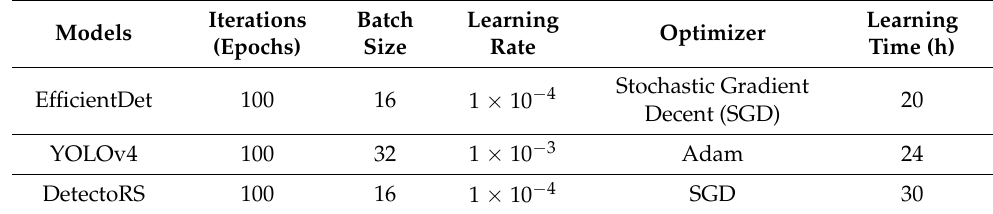
Table 2. Hyperparameter